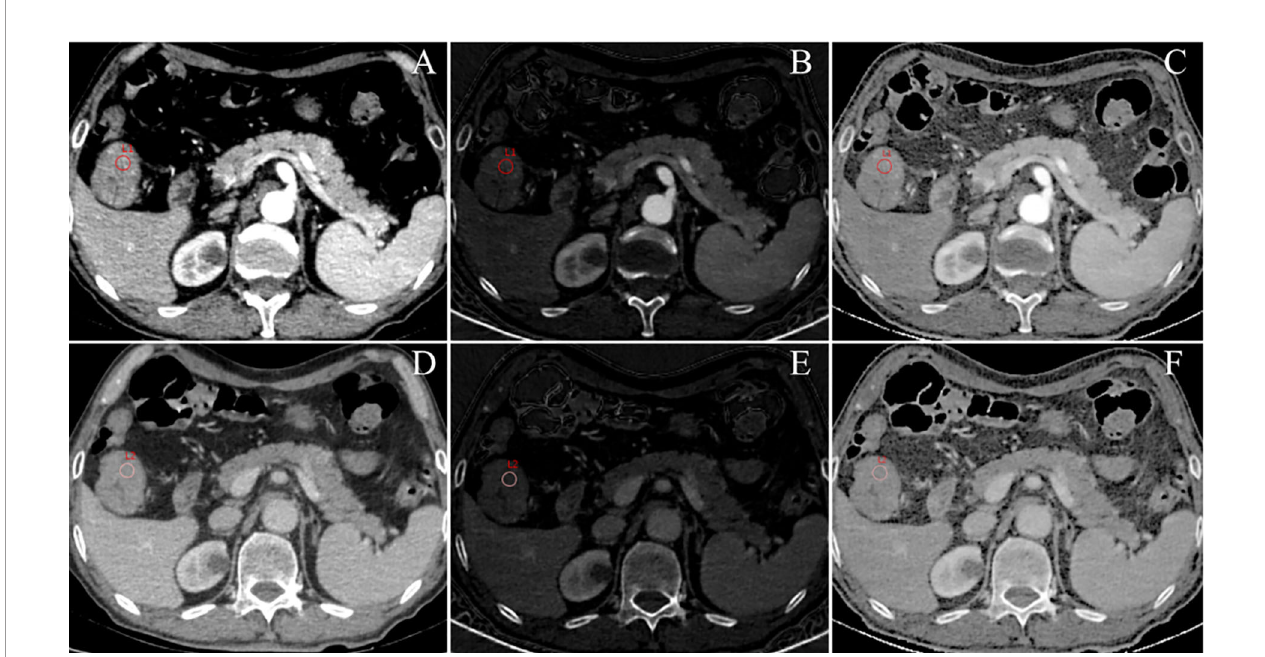
FIGURE 3 | An example of DESCT images with ROIs for evaluating quantitative measurements in a 75-year-old man with ascending colon cancer that was pathologically con fi rmed to have non-metastatic lymph nodes. ROIs were placed in the arterial phase (A) and the venous phase (D) of the 70-keV monochromatic images. At the same time, ROIs were copied to the arterial phase (B) and the venous phase (E) of iodine-based material decomposition images and the arterial phase (C) and venous phase (F) of the effective atomic number